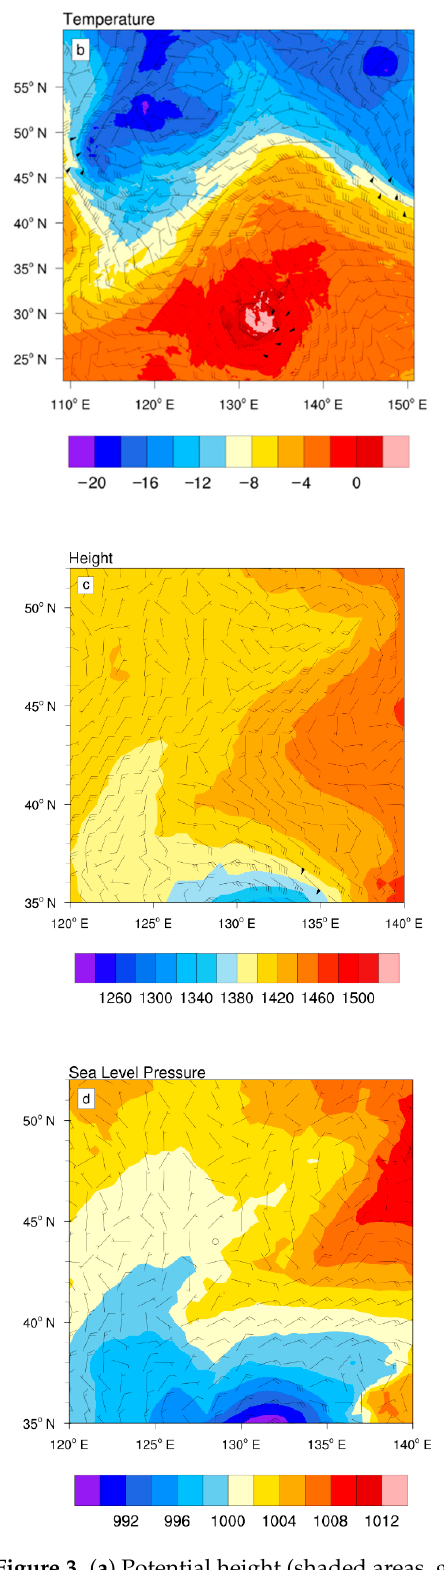
Figure 3. ( a ) Potential height (shaded areas, gpm) and horizontal winds (barbs, kts) at 500 hPa; ( b ) Temperature (shaded areas, °C) and horizontal winds (barbs, kts) at 500 hPa; ( c ) Potential height (shaded areas, gpm) and horizontal winds (barbs, kts) at 850 hPa; ( d ) Pressure (shaded areas, hPa) and horizontal winds (barbs, kts) at sea level at 19 UTC on 14 August 2019.